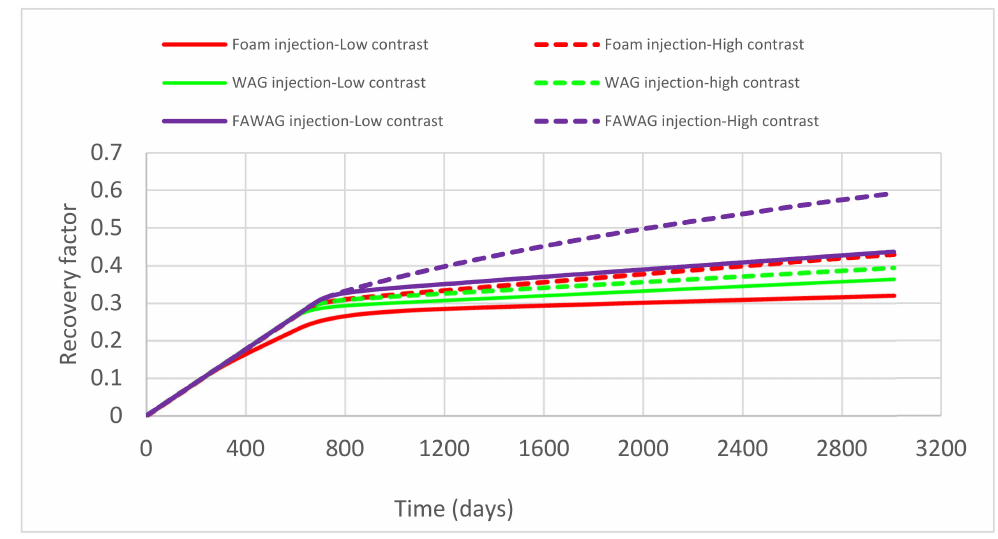
Figure 19. The impact of permeability contrast on oil recovery for foam (red), WAG (green), and FAWAG (purple) injection